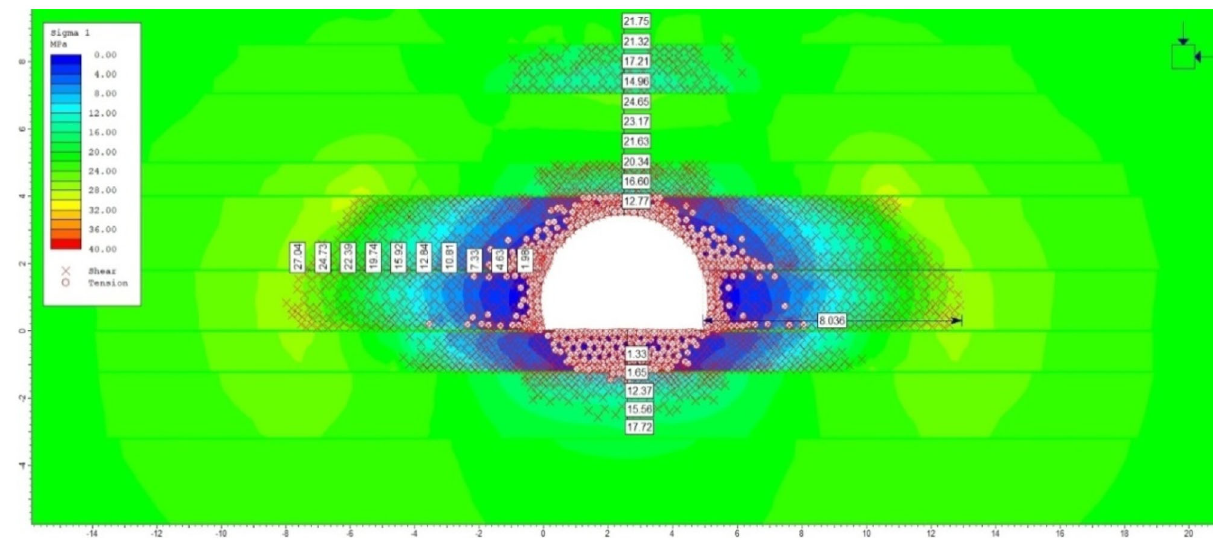
Fig. 11 Major principal stress r 1 with yielded elements of Case 1